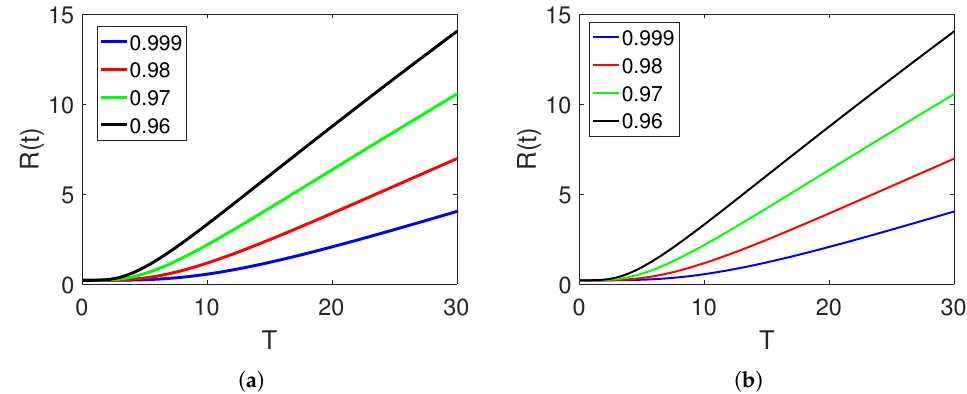
Figure 17. Comparison of Newton polynomial ( a ) and LADM ( b ) for fifth class on different arbitrary fractional order.